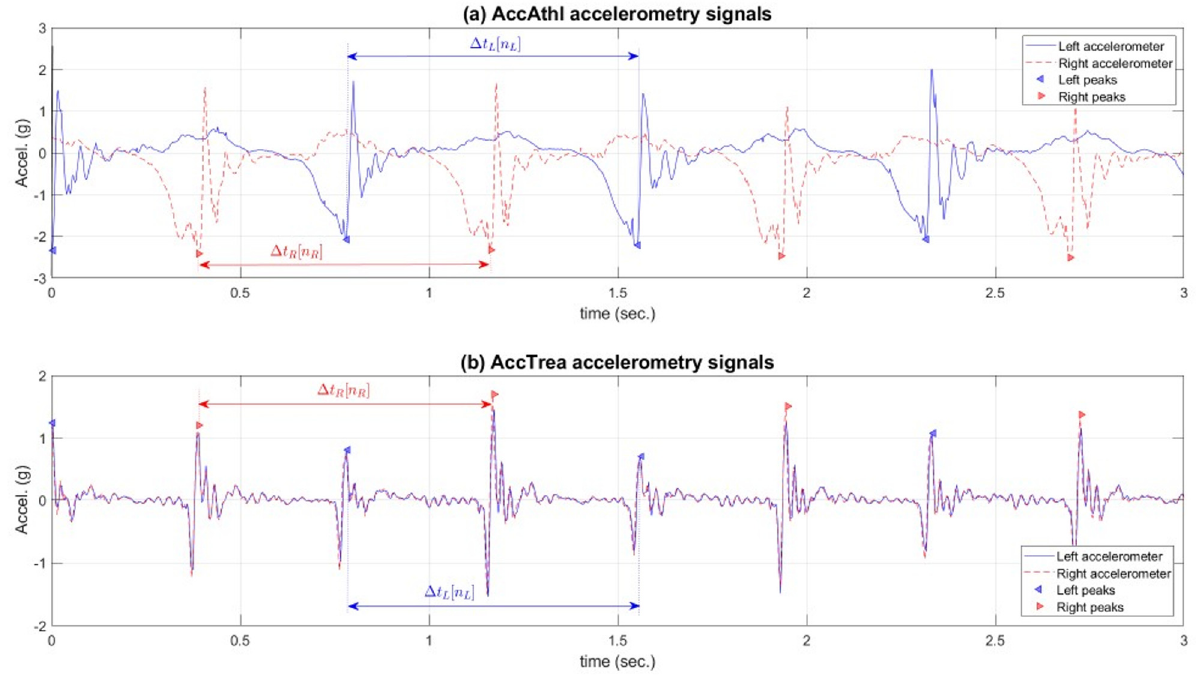
Figure A3. Comparison of the accelerometry signals from the system AccAthl ( a ) and the two-accelerometer approach AccTrea ( b ). The solid and dashed line display the accelerations corresponding to the left and right legs, respectively. The left- and right-pointing triangles mark the acceleration peaks of the left and right legs, respectively.